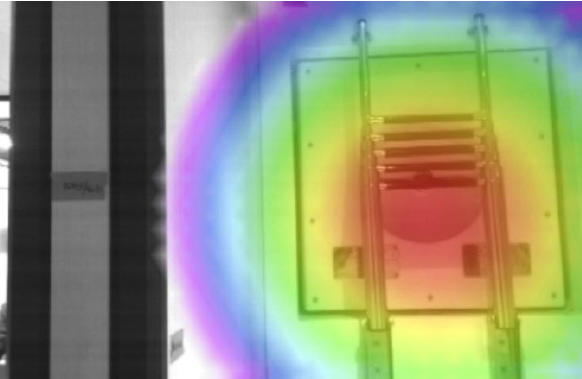
Figure 7. Sound energy leakage of the Stbd Vip Cabin—Engine Room partition. Frequency: 250–500 Hz.